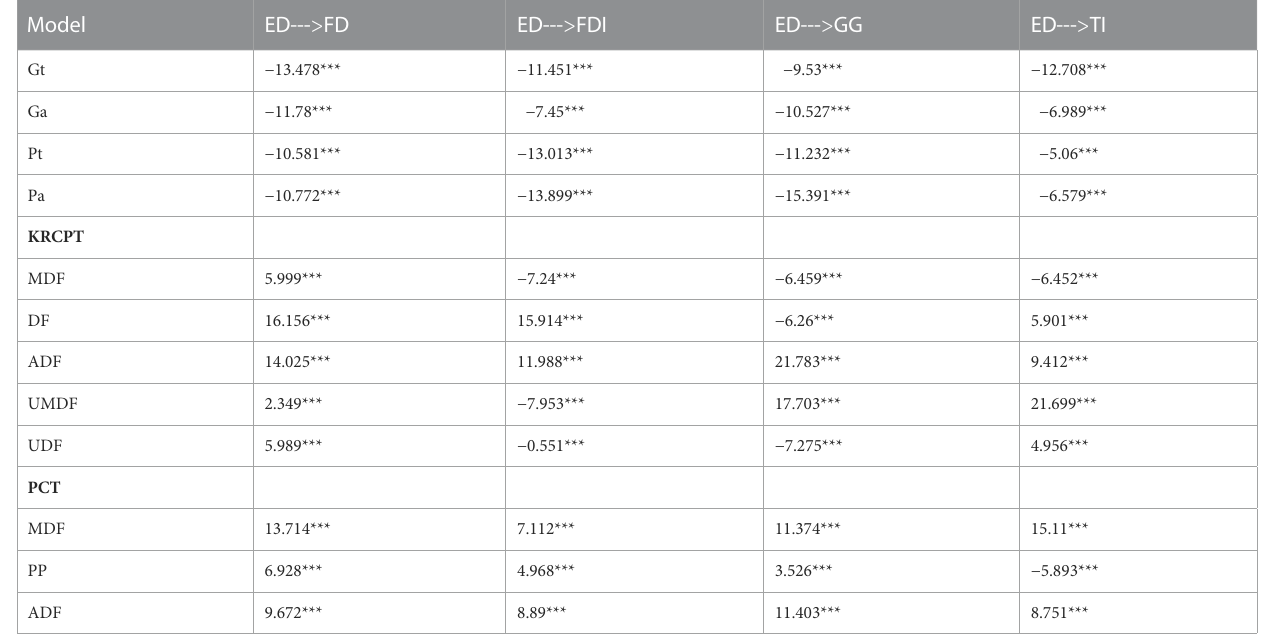
TABLE 9 Results of